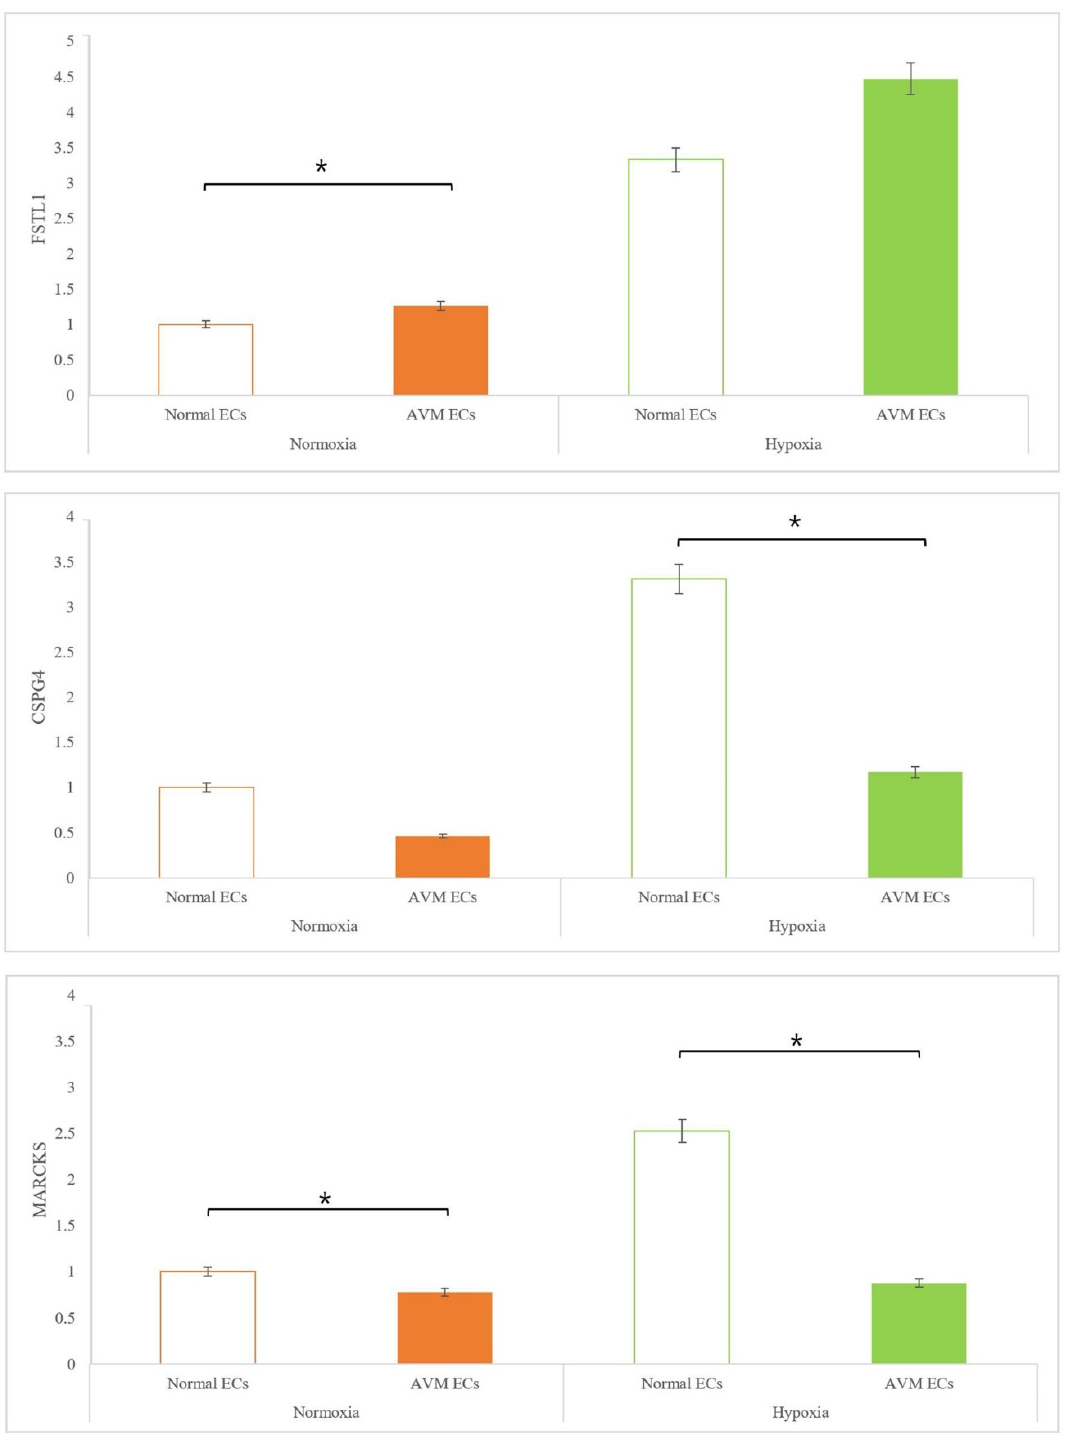
Figure 5. Expression levels of three target genes, FTSL1 , CSPG4 , MARCKS . Expression levels, detected using real-time PCR, were increased in hypoxia than normoxia. In hypoxia, the expression of FSTL1 increased more than that of CSPG4 and MARCKS . * p < 0.05. FSTL1 , follistatin-like 1; MARCKS , myristoylated alanine-rich C-kinase substrate; CSPG4 , chondroitin sulfate proteoglycan